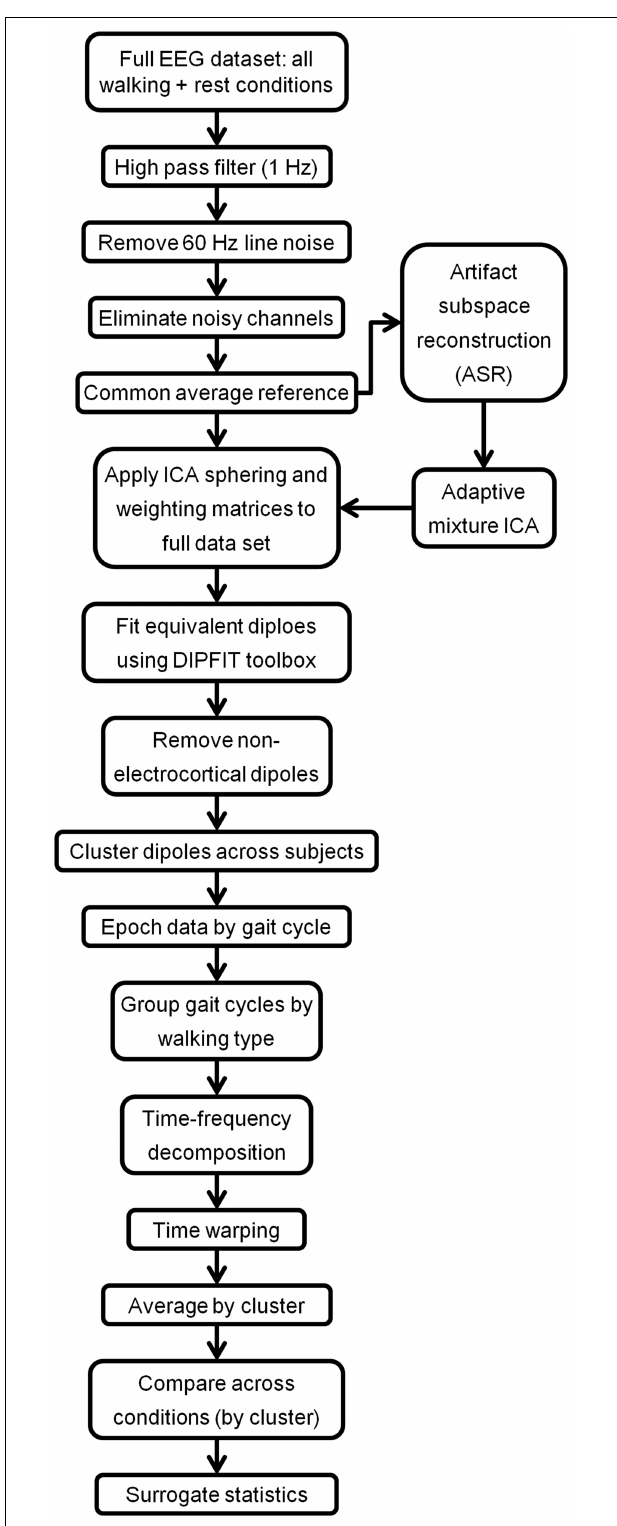
FIGURE 2 | Flow-chart indicating the EEG processing pipeline for treadmill